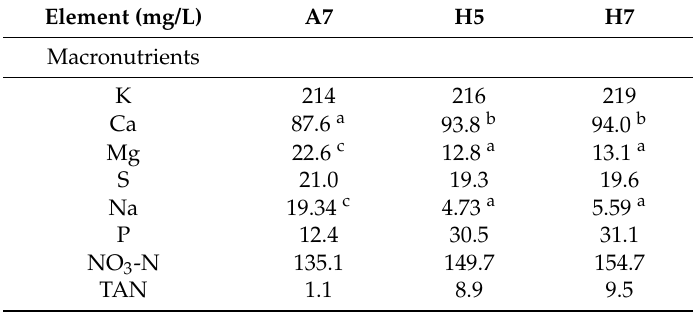
Table 2. Nutrient solutions for treatments employed (SA7 same as A7) expressed in mg/L. Differing superscript letters within response variables identify that significant differences occur between values ( p -level = 0.05), from Reference